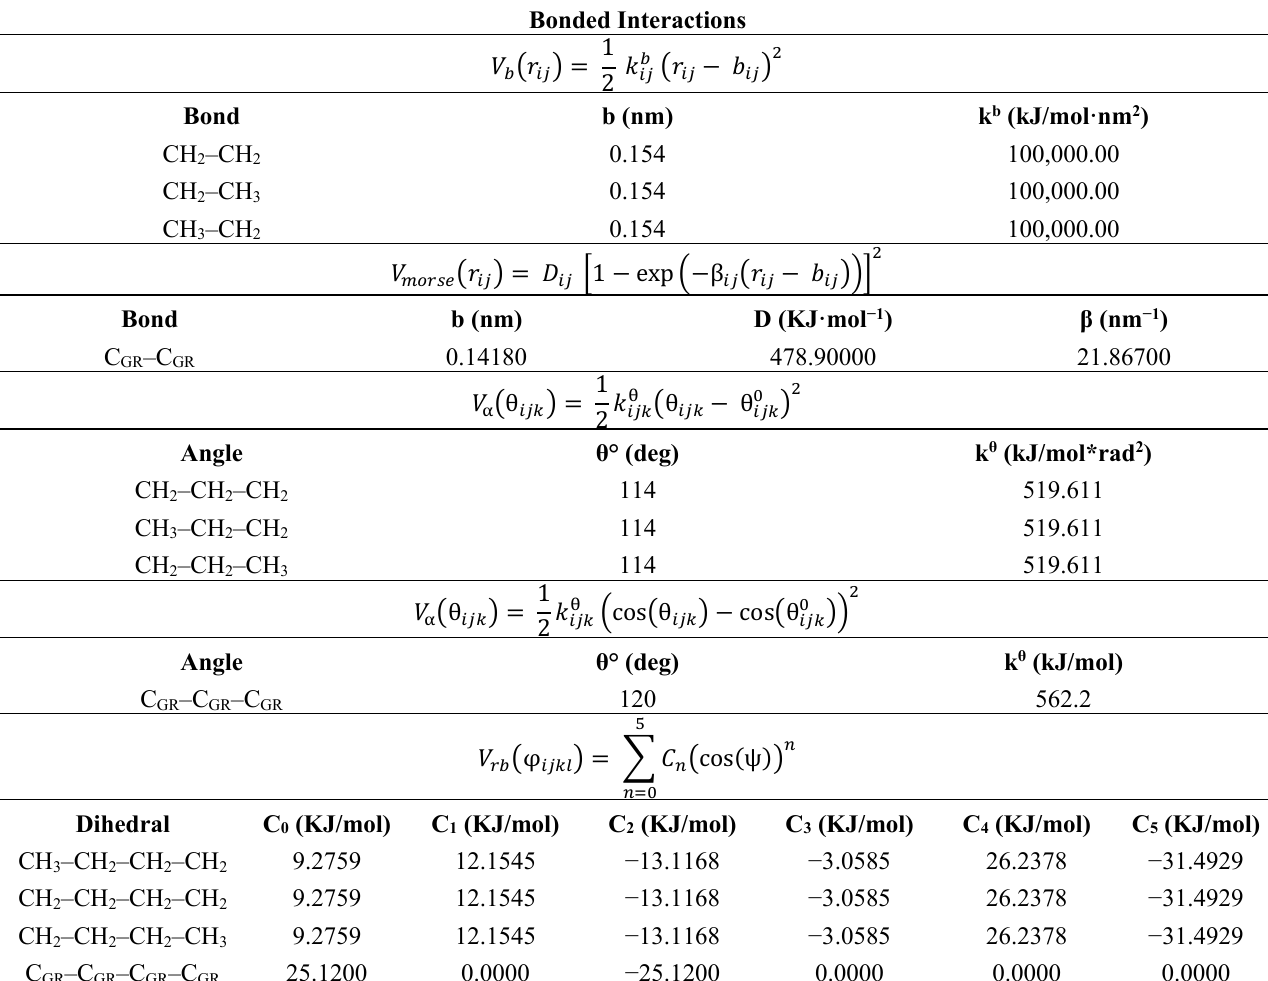
Table A2. Model parameters and functional forms of all bonded interactions of the atomistic force field used